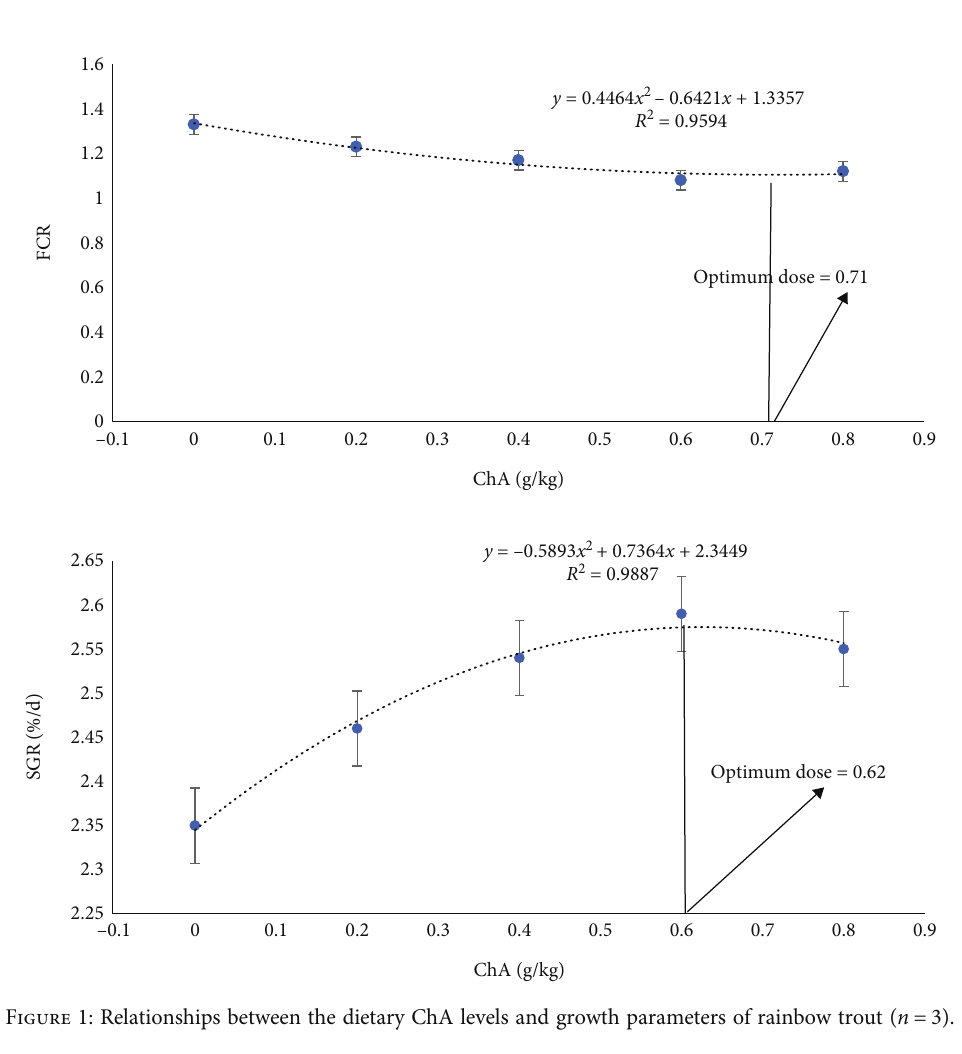
Table 2: The growth performance of O. mykiss fed with di ff erent levels of ChA after a 60-day feeding trial. Parameter IW (g) FW (g) Control